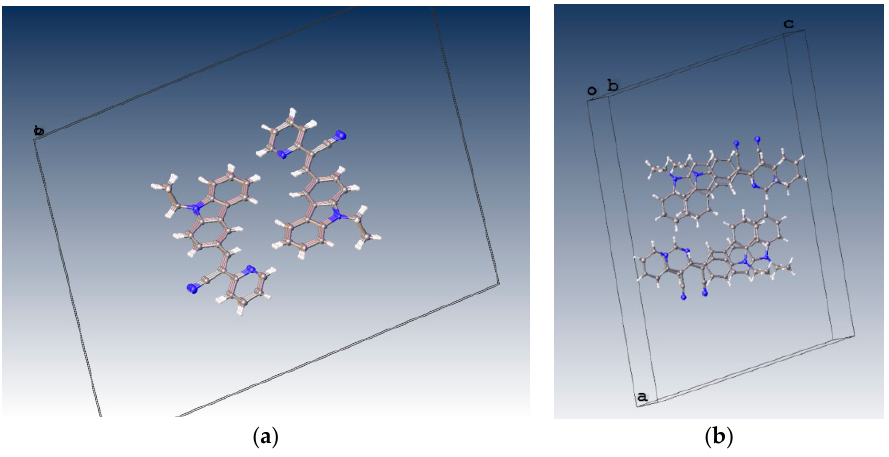
Figure 9. Molecular packing of III in the unit cell view from b axis ( a ) and from c axis ( b ).